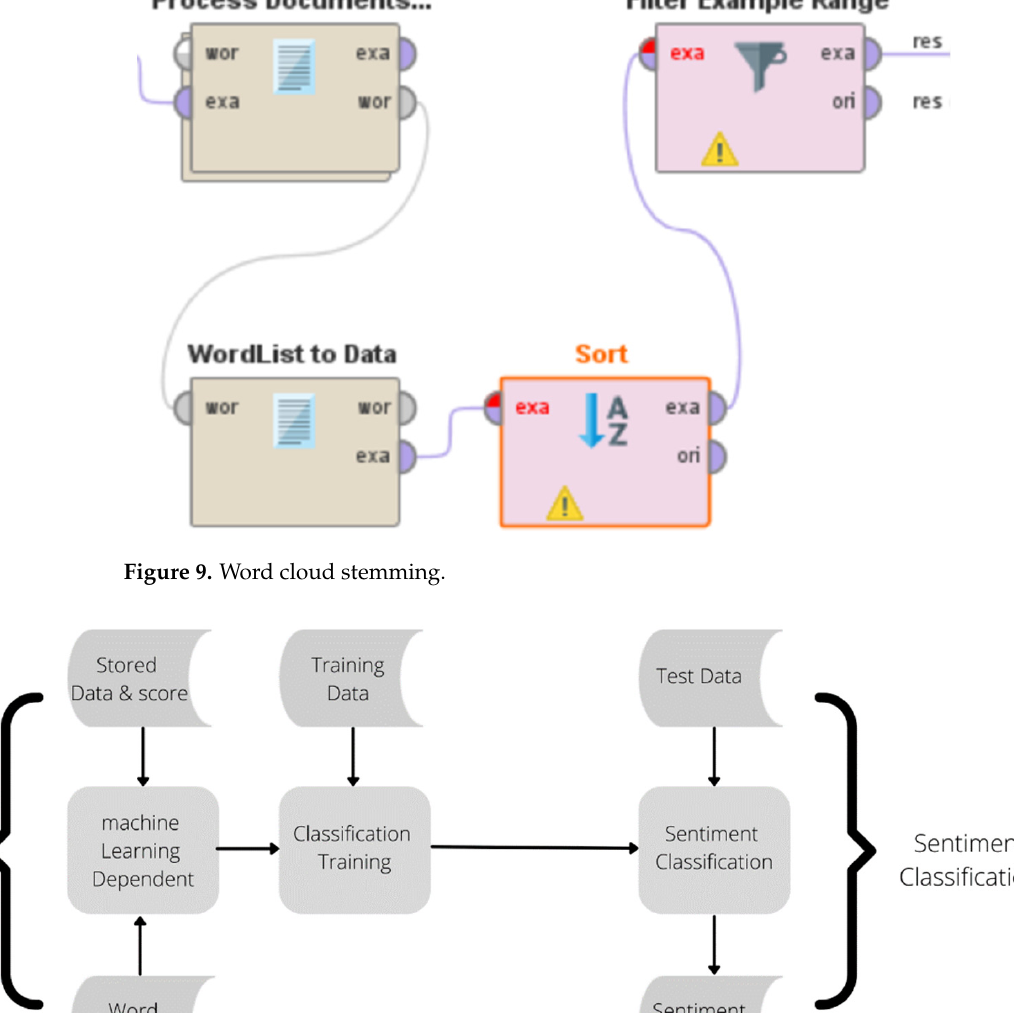
Figure 8. Word cloud as word list.